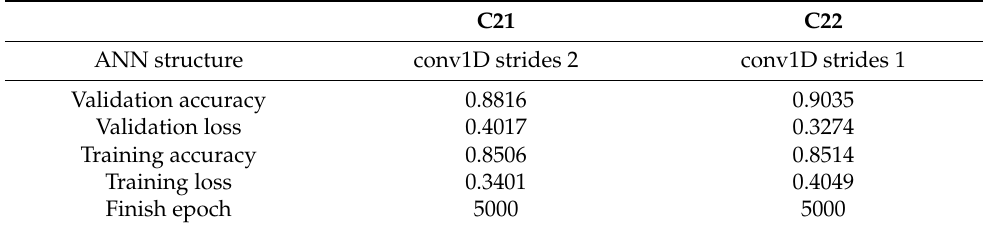
Table 9. Convolutional layer strides parameter tuning